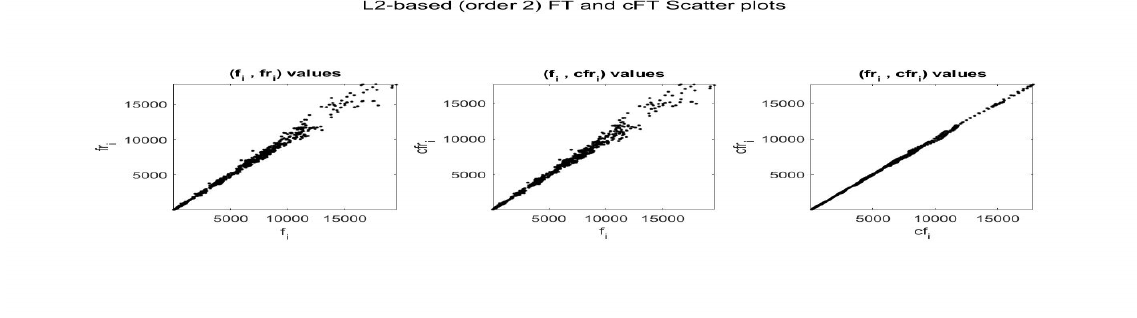
( t ) and f q ( t ) using L 2 -norm F-transform j j ( P b , A , r ) c , ( P b , A , r )